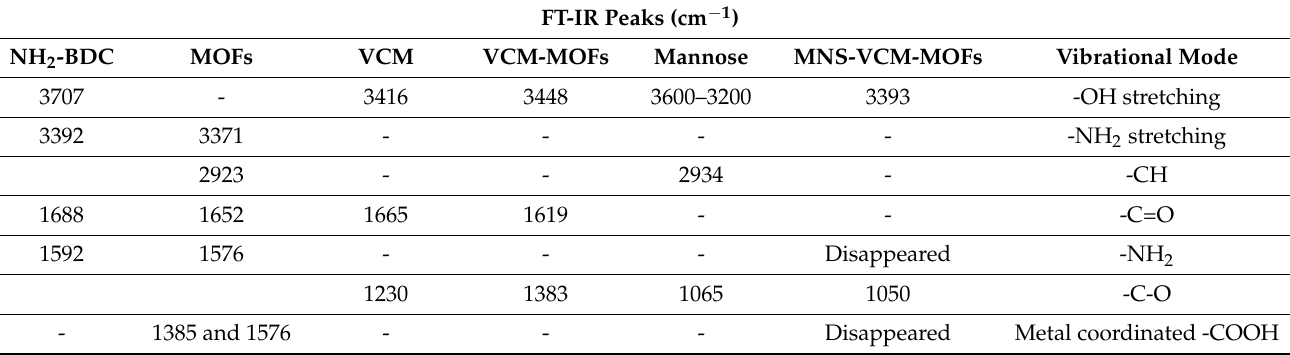
Table 1. FT-IR assignment of NH 2 -BDC, MOFs, VCM, VCM-MOFs, MNS, and MNS-VCM-MOFs.